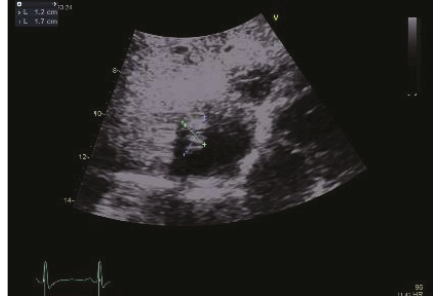
Figure 8: Tumor recurrence one week after surgical